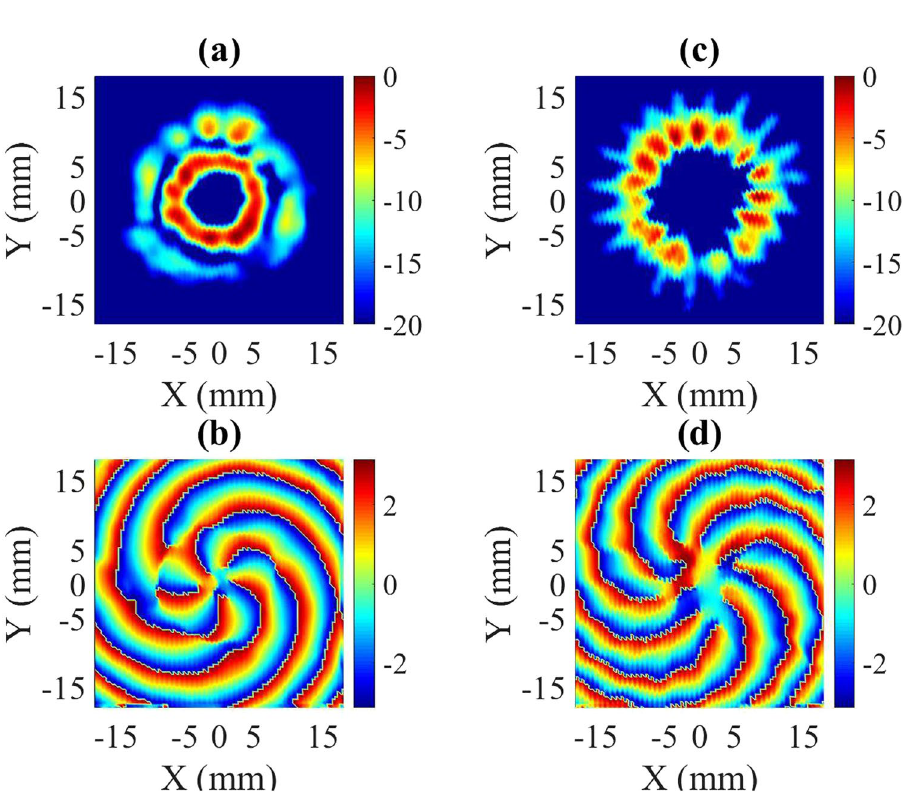
Figure 9. Time-averaged measured ( a ) amplitude and ( b ) phase of the electric field of the TE 6,2 mode at 95.29 GHz and the time-averaged measured ( c ) amplitude and ( d ) phase of the electric field of the TE 10,1 mode at 98.58